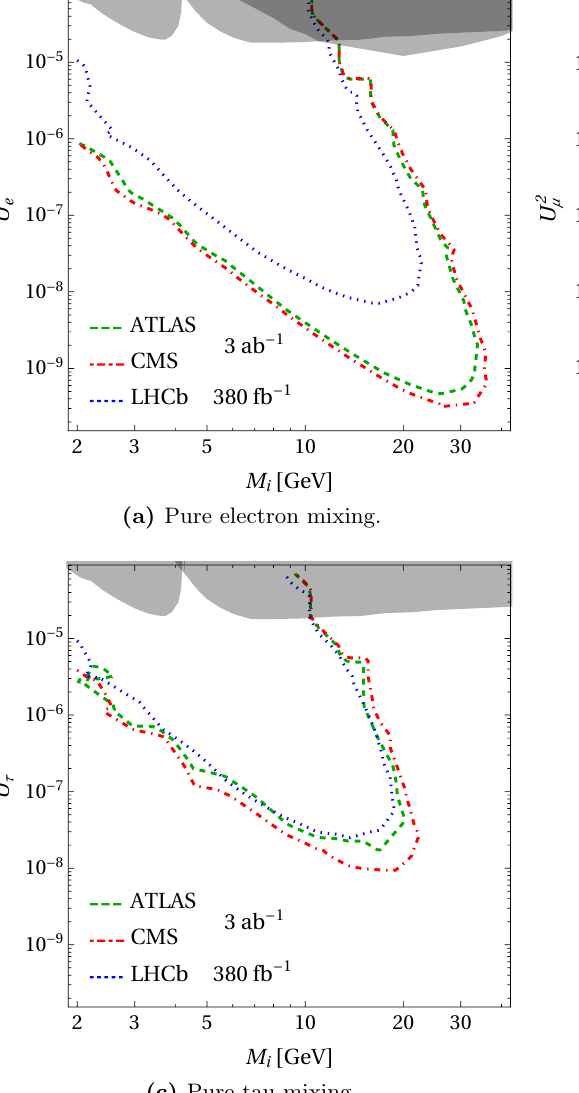
decays, and (cid:12)gure 8 illustrates how the LHCb sensitivity depends on the part of the tracker that is used for the displaced vertex